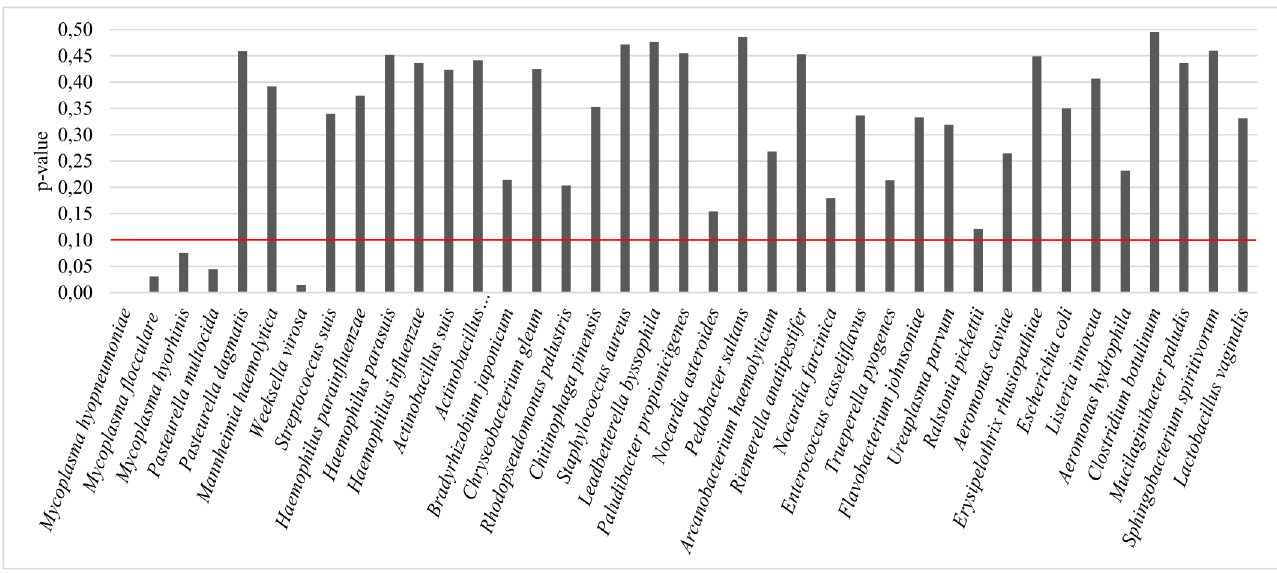
Fig 4. p-values of the ratio of mapped reads between samples. The x-axis shows the most prevalentbacteriaspecies reported. The y-axis shows the p-valuesfrom normalized ratio of mappedreads. The red line represents the significantthreshold set at an α = 0.10.